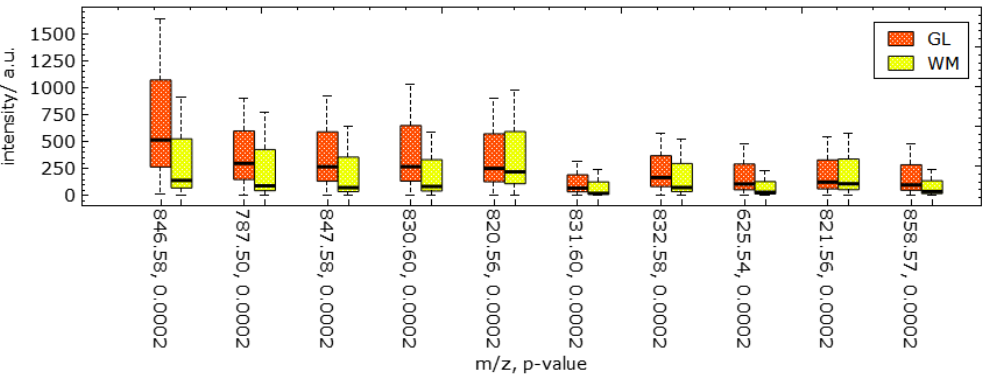
Figure 18. Juxtaposed boxplot visualization allows for quantitative comparative analyses of peak intensity distributions of selected image regions (cf. Figure 17) for selected discriminant